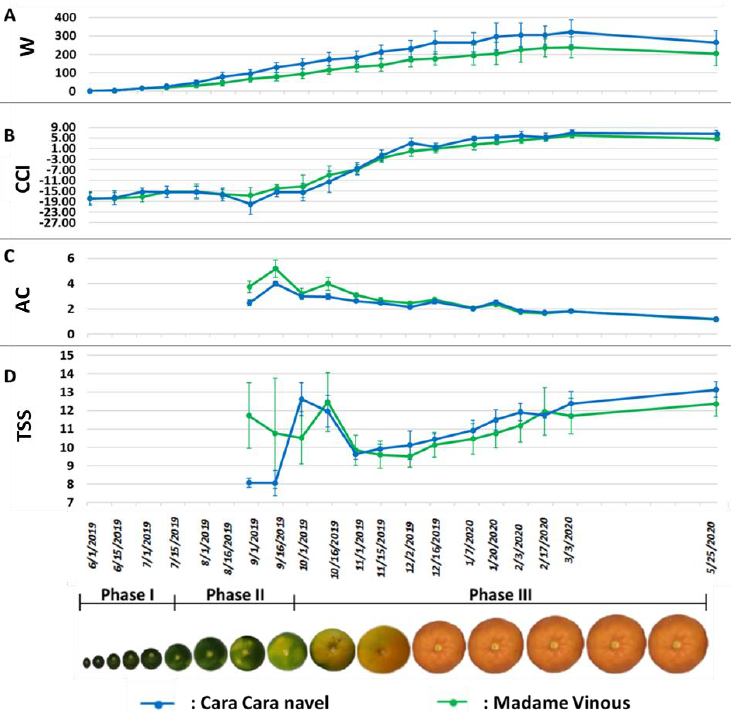
Figure 1. Dot plots representing the evolution of phenological parameters at different dates of fruit development. The vertical bar on each dot represents the standard deviation. ( A ) fruit weight (W) (in g); ( B ) citrus color index (CCI) of the flavedo; ( C ) titrated acidity (AC) expressed in % of citric acid; and ( D ) total soluble solid (TSS) content expressed in °Brix.